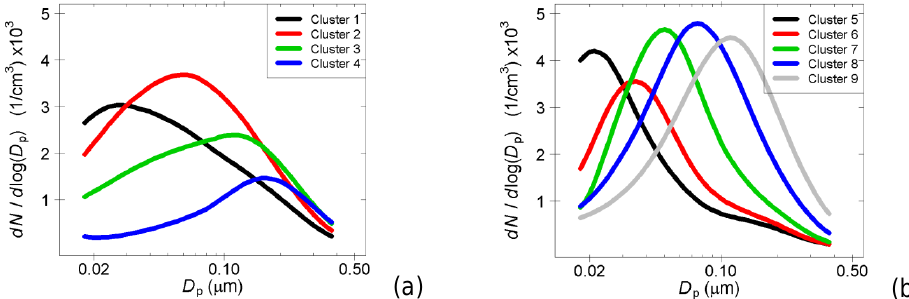
Fig. 2. Average cluster spectra resulting from the cluster analysis of the daily mean spectra collected at each of the 24 EUSAAR sites. (a) Clusters 1, 2 and 3 are the broad central European spectra and the Arctic spectrum 4 and (b) Clusters 5, 6, 7, 8 and 9 are the narrower size distributions observed at sites outside of the central European